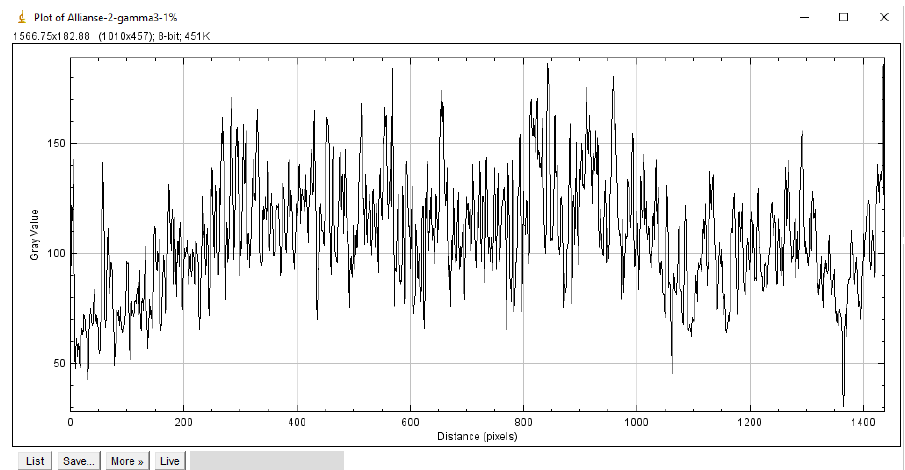
Figure 3. Histogram for a single measurement line.